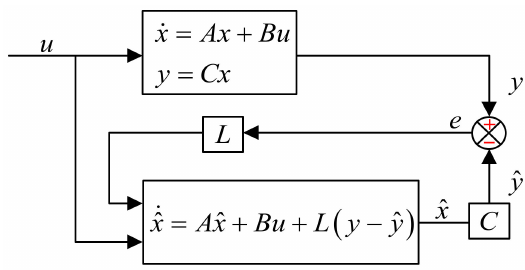
Figure 3. Luenberger